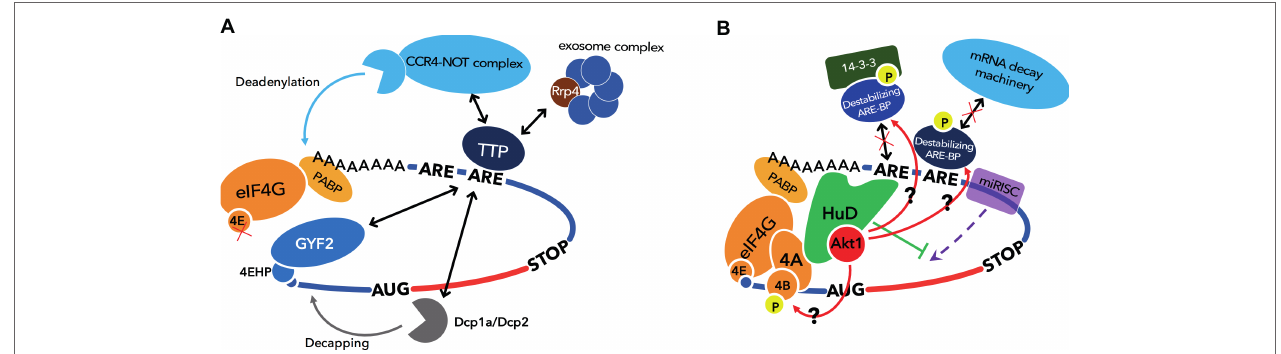
FIGURE 2 | Functional model of destabilizing ARE-BP, TTP and stabilizing ARE-BP, HuD. (A) TTP induces mRNA decay by recruiting CCR4-NOT complex, exosome complex, and Dcp1a/Dcp2 complex and represses translation by recruiting 4EHP via binding GYF2. (B) HuD stimulates translation via direct binding to eIF4A and the poly(A) tail. miRISC represses translation by dissociation of eIF4A from the translation initiation complex, and this inhibitory effect on translation initiation is attenuated by HuD. HuD also binds Akt/PKB, which phosphorylates destabilizing ARE-BPs such as KSRP, TTP, ZFP36L1, and ZFP36L2 to inactivate them, and eIF4B to stimulate helicase activity of